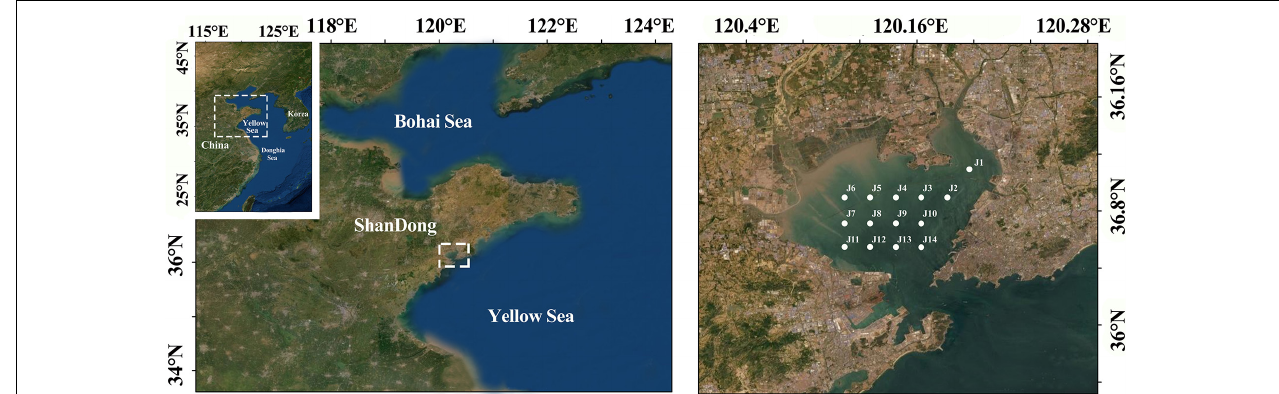
FIGURE 1 | Study area and locations of sampling sites in coastal waters of Jiaozhou